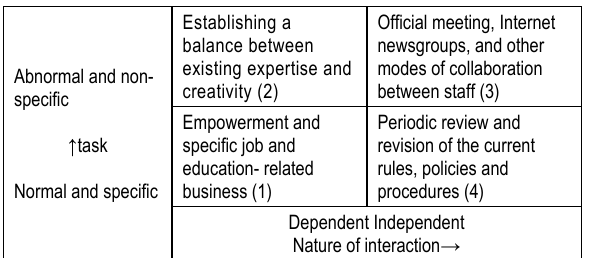
Table 2. The relationship between